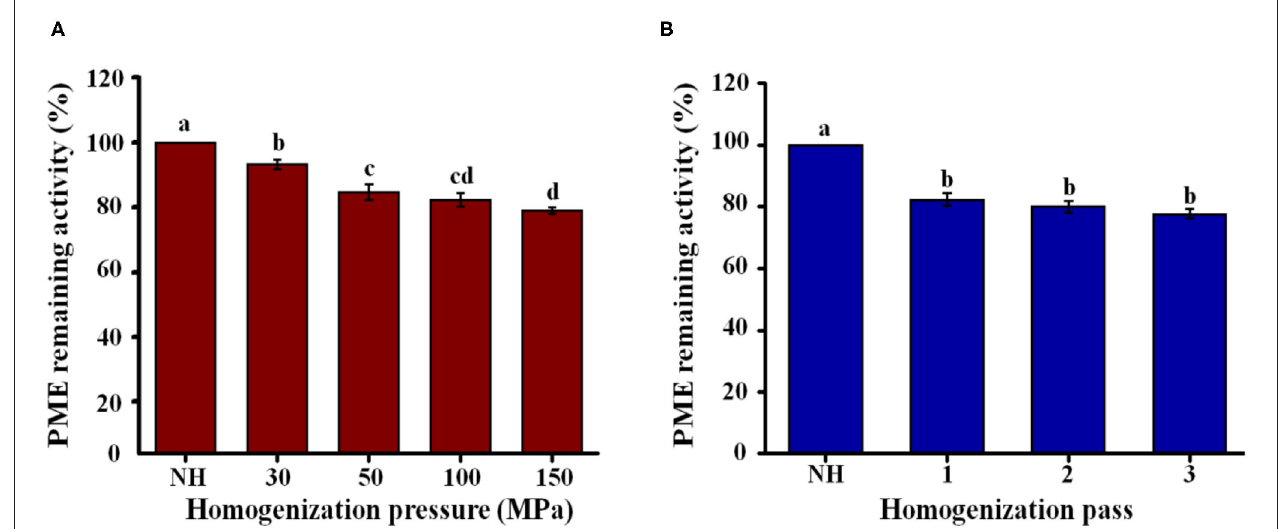
FIGURE 6 | Effect of HPH treatments on PME activity of NFC orange juice. (A) Homogenization pressure; (B) Homogenization pass.